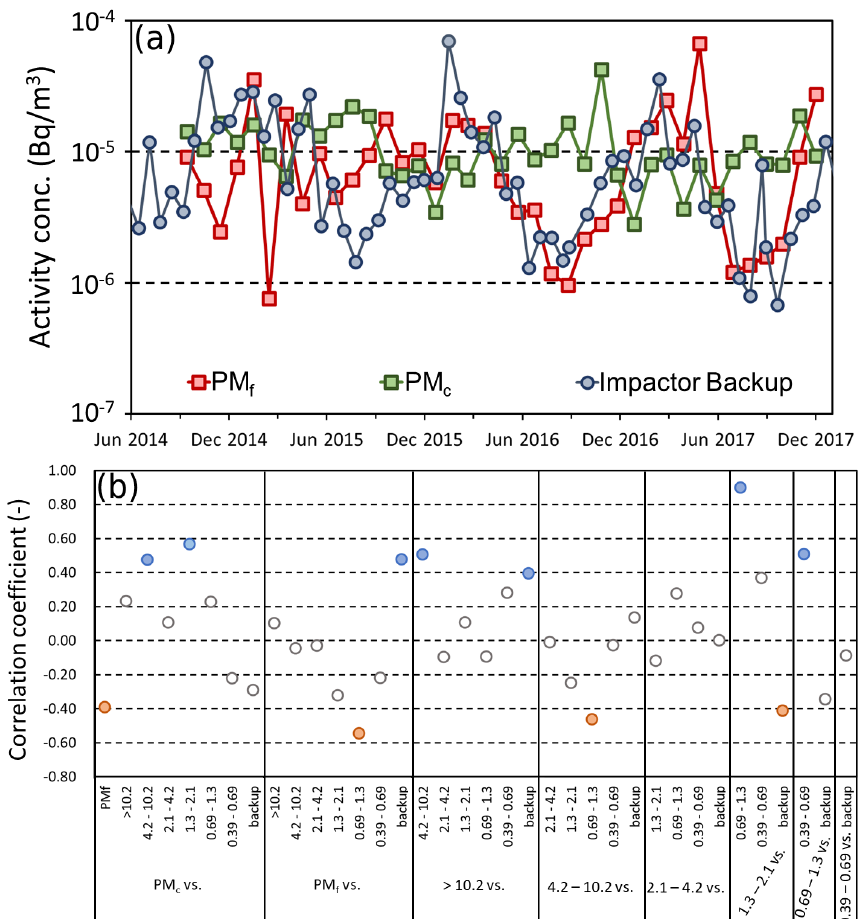
Figure 5. (a) Time series of airborne surface concentrations of 137 Cs in PM f (0.1–2.5µm) and PM c ( > 2 . 5µm) collected by the impactor– cyclone system and those of the backup filter of the cascade impactor. (b) Correlation coefficients of temporal variations among seasonal mean 137 Cs concentrations of different sizes measured by the impactor–cyclone system and the cascade impactor. Correlation coefficients higher than approximately 0.4 and lower than approximately − 0 . 4 are colored blue and orange,